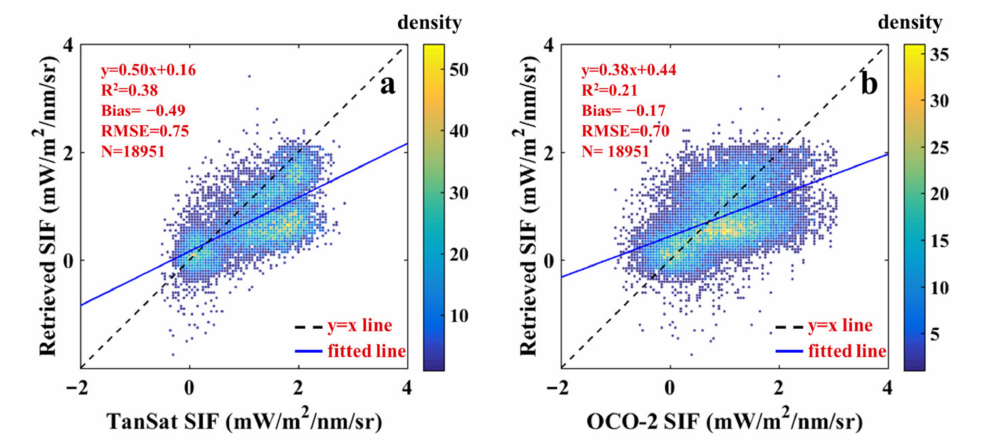
Figure 5. Scatter plots of SIF retrievals compared with TanSat SIF ( a ) and OCO-2 SIF ( b ). The color legend indicates the density of scattered